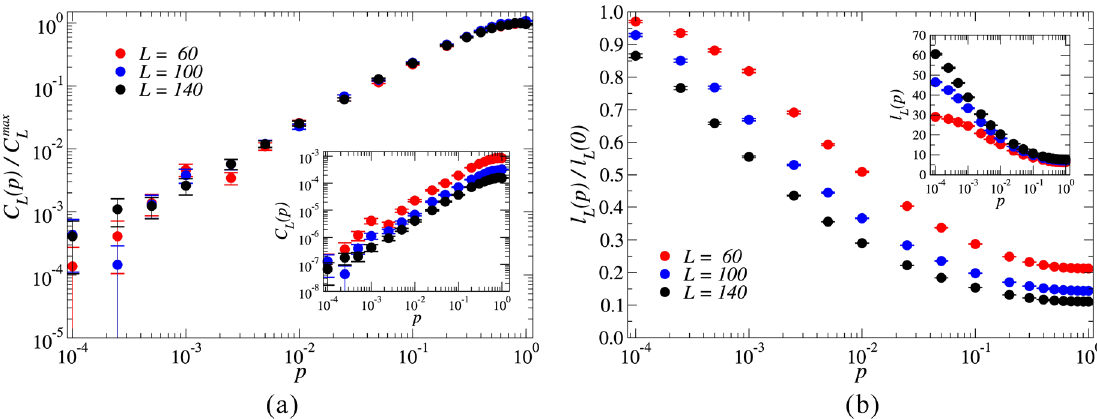
Figure 3. ( a ) Average clustering coefficient C L ( p ) of networks with L = 60, 100, 140 , built according to the link-rewiring scheme as a function of p . Each data point averages over 1000 different networks. The rates of growth of the C L ( p ) seem to be universal and consistent, irrespective of the values of L explored in this work, as denoted by the collapse of the curves of C L ( p )/ C max L . ( b ) Average shortest path length ℓ L ( p ) of networks with L = 60, 100, 140 built according to the square lattice link-rewiring scheme as a function of p . Each data point averages over 100 different